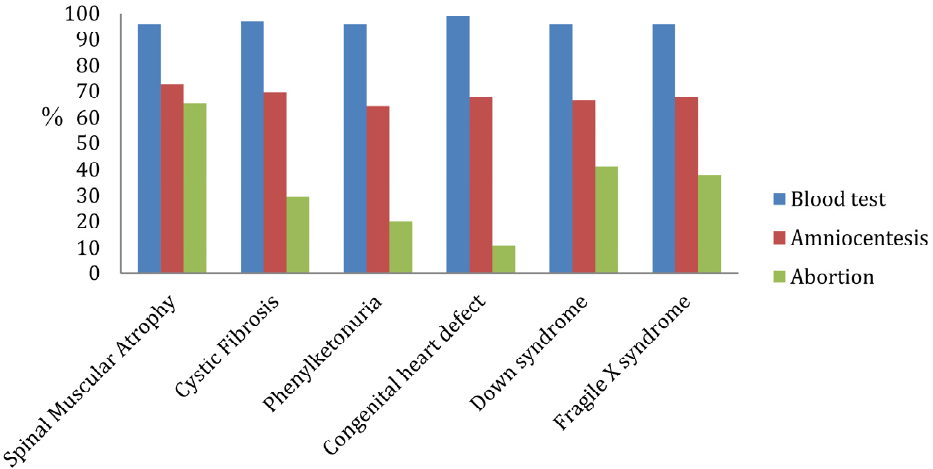
Figure 1. Proportion of patients indicating they would definitely or probably undergoing screening (blood test), diagnostic testing (amniocentesis) or pregnancy termination for each